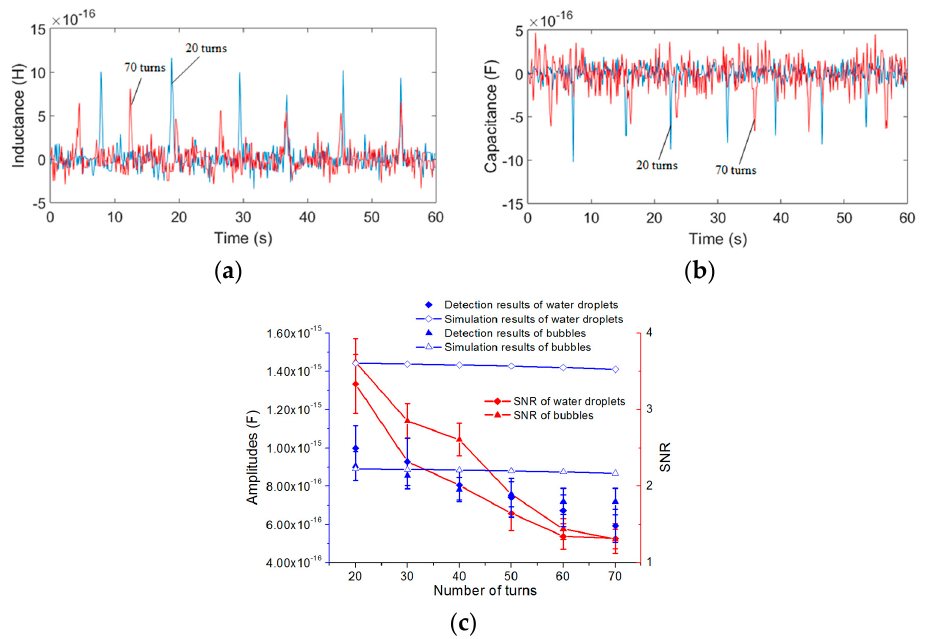
Figure 10. Capacitance detection results and theoretical inductance changes for different numbers of turns (frequency was 0.3 MHz): ( a ) detection results of water droplets with sizes ranging from 190 to 200 μ m, red line was 70 turns and blue line was 20 turns; ( b ) detection results of bubbles with sizes ranging from 260 to 280 μ m, red line was 70 turns and blue line was 20 turns; ( c ) comparison between the experimental results and the analytical predictions for different numbers of turns.